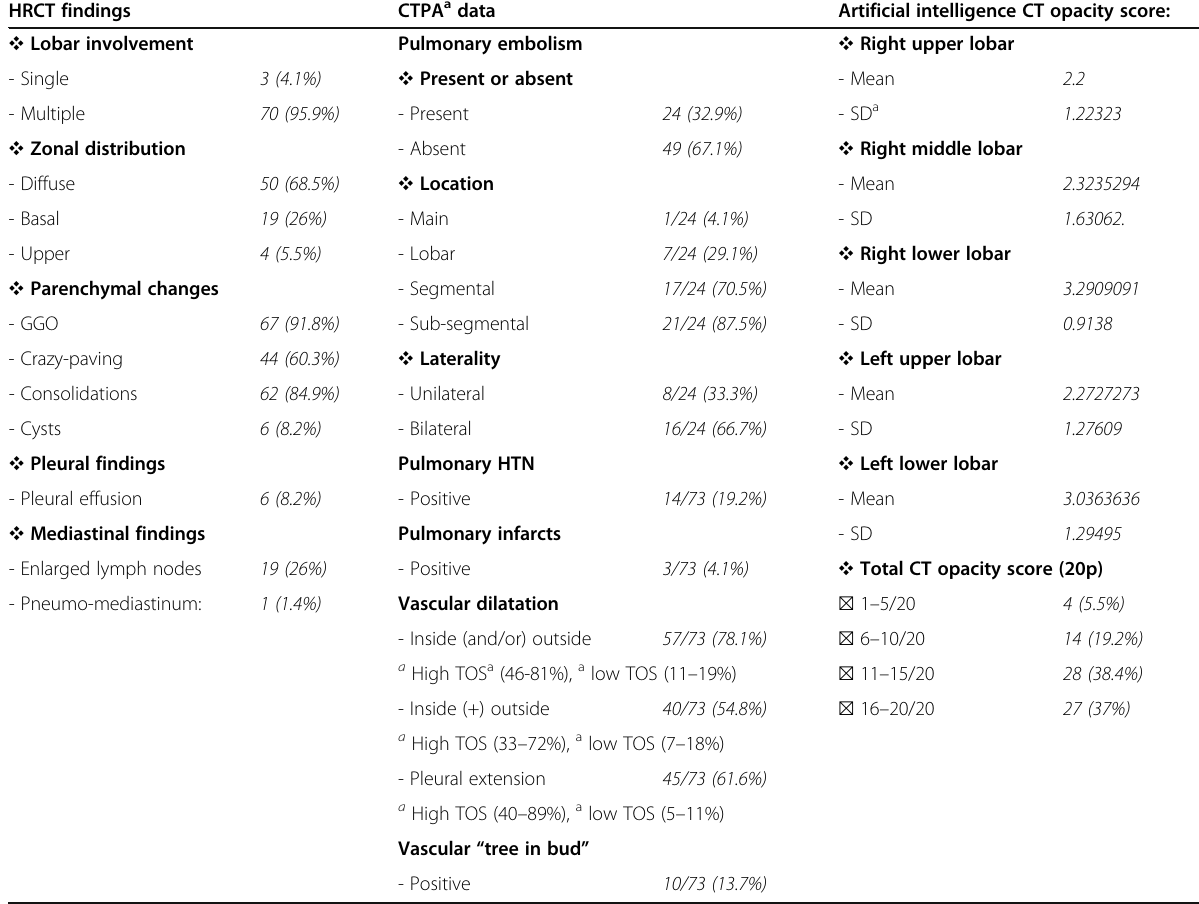
Table 2 Distribution of patients according to HRCT findings, CTPA data, and artificial intelligence CT opacity score